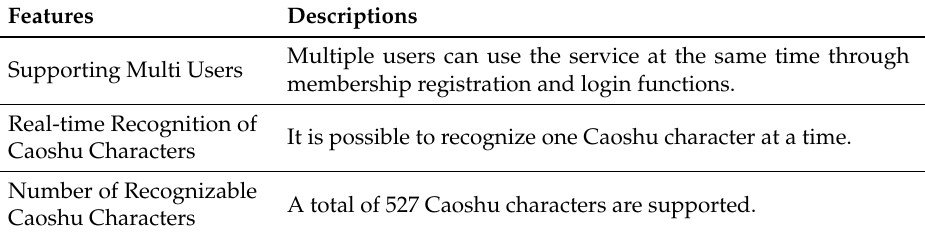
Table 7. Main functionalities of the implemented online Caoshu recognition